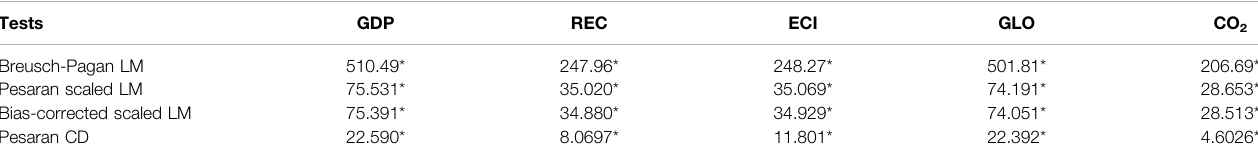
TABLE 3 | CSD tests.